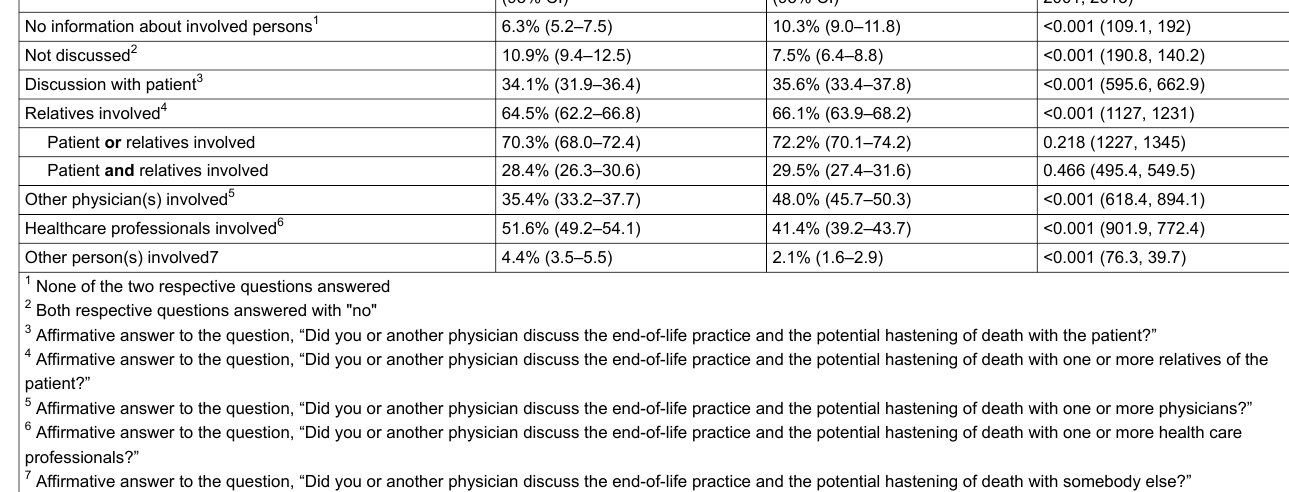
Table 3: Persons involved in medical end-of-life decisions, German-speaking part of Switzerland 2001 vs 2013 (multiple answers allowed). (100% = all deaths with reported end-of-life practice; percentages weighted and standardised to 2013 deaths). Deaths with end-of-life practice mentioned (eligible for